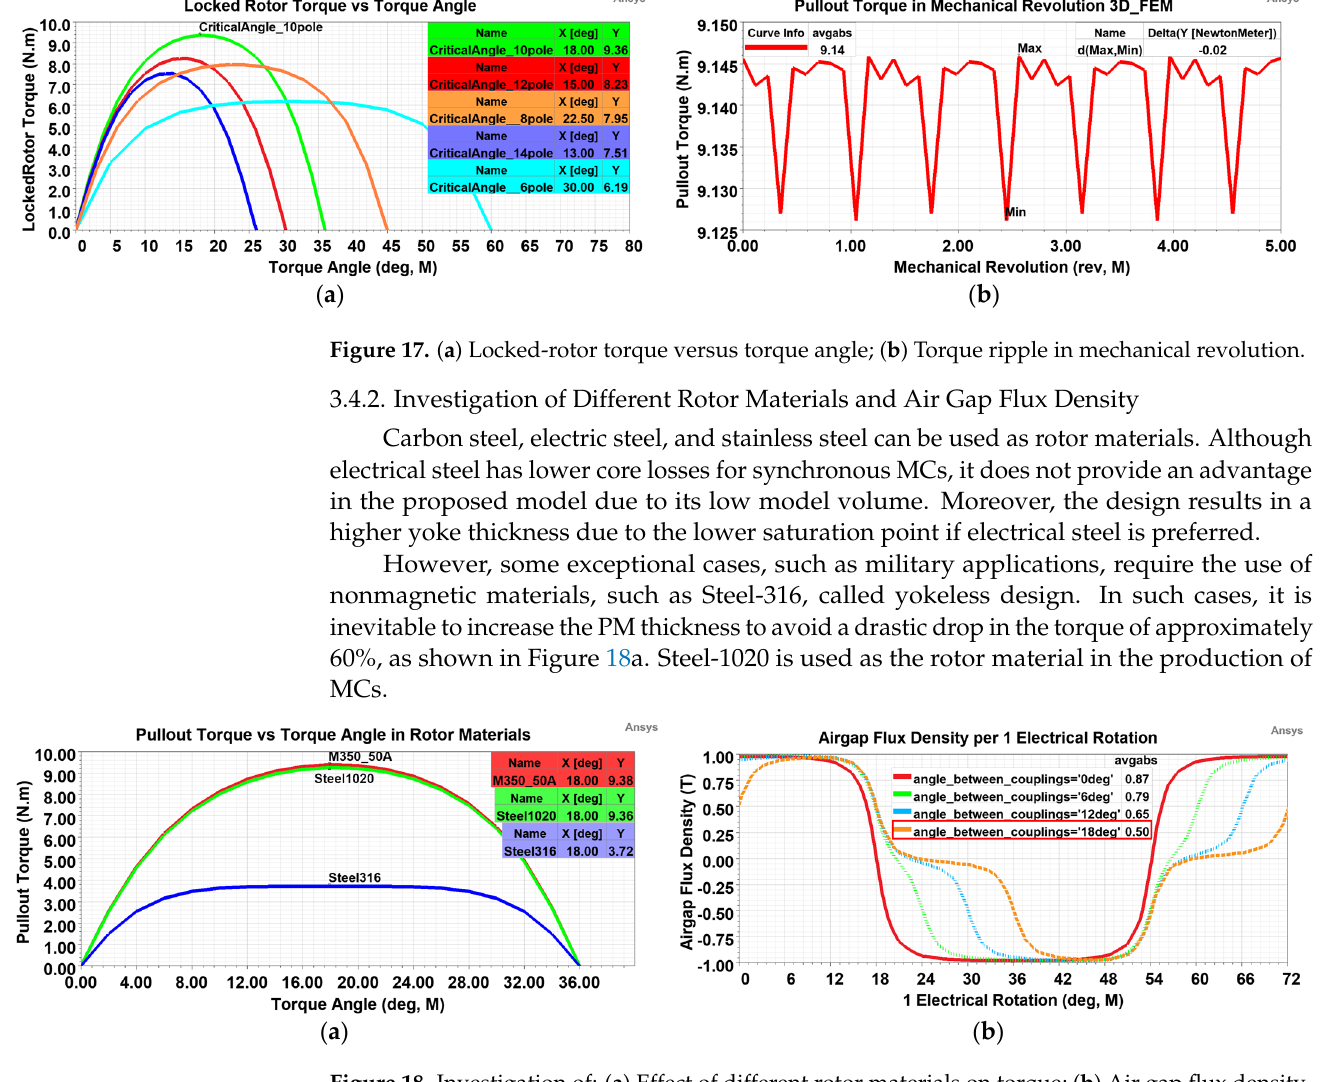
Figure 18. Investigation of: ( a ) Effect of different rotor materials on torque; ( b ) Air gap flux density.